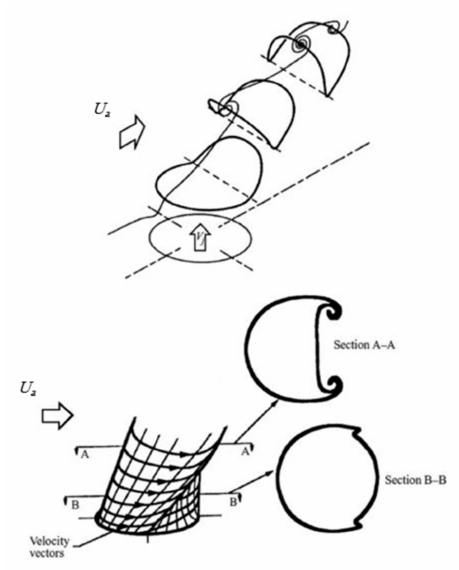
Figure 9. Interpretation of JICF tilting, folding, and reorientation of shear-layer vortex rings and eventual formation of CRVP taken from Kelso et al.